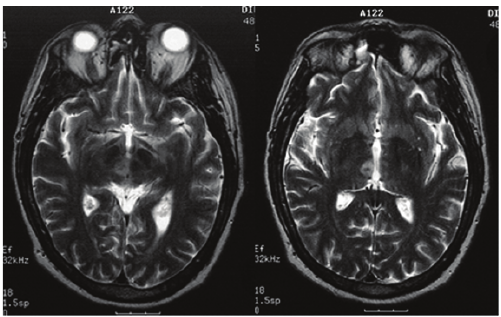
Figure 2: Brain MRI (T2 weighted) of the patient SD showing the acute ischemic lesion confined to the right paramedian thalamus extending to the mesencephalic